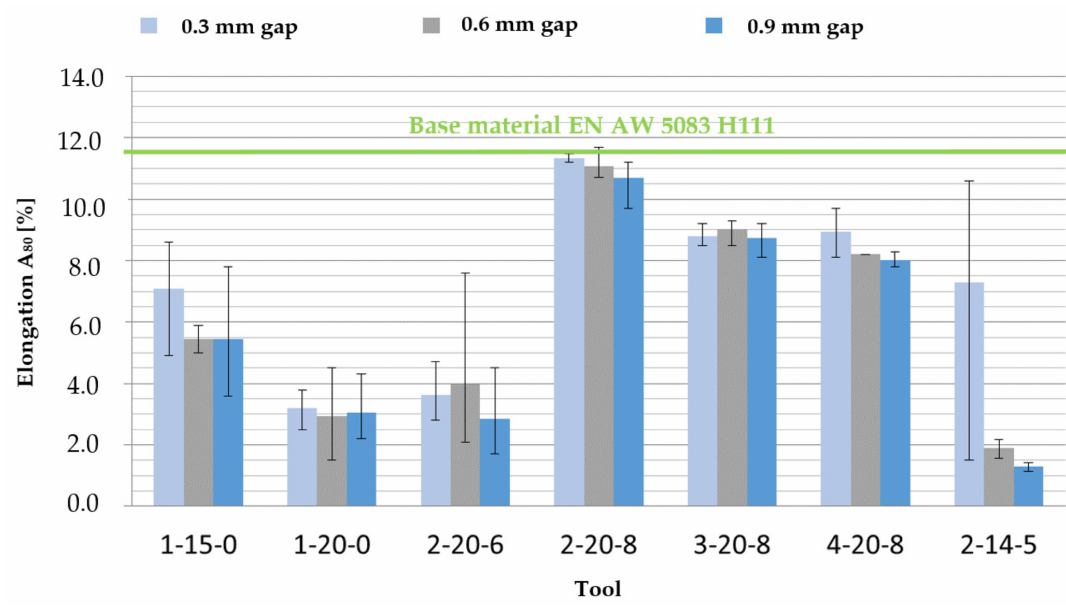
Figure 14. Comparison of the elongation at break of welded joints on the material EN AW 5083 H111. Cross Sections